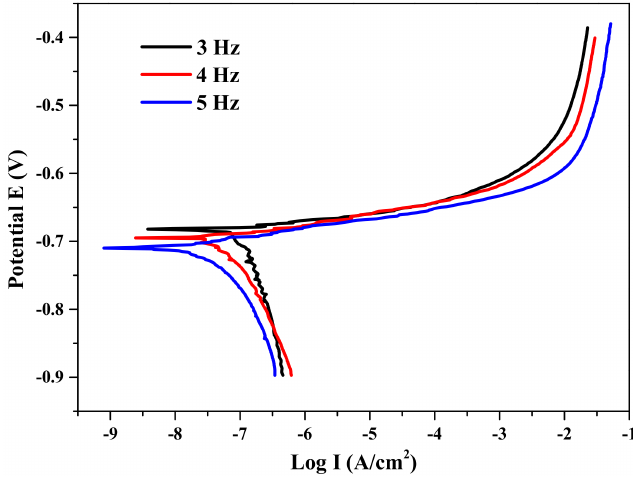
Figure 14. Potentiodynamic polarization curves of welded joint produced by different thermal